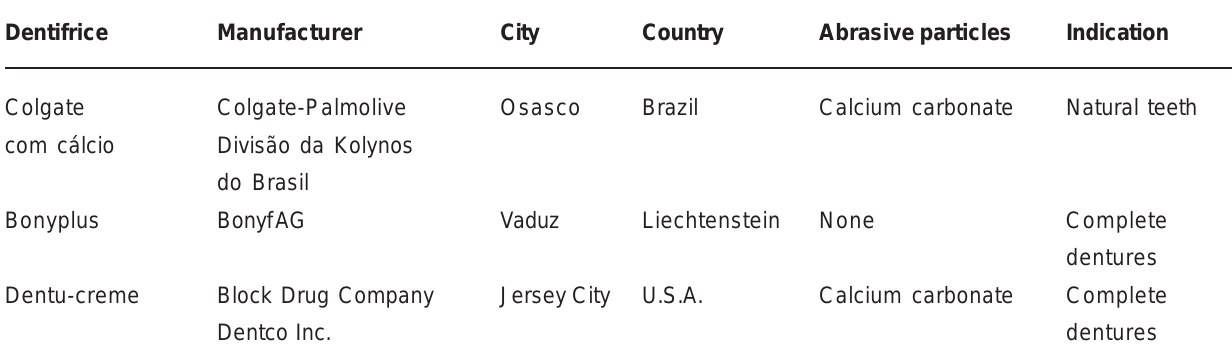
TABLE 2- Characteristics of dentifrices employed